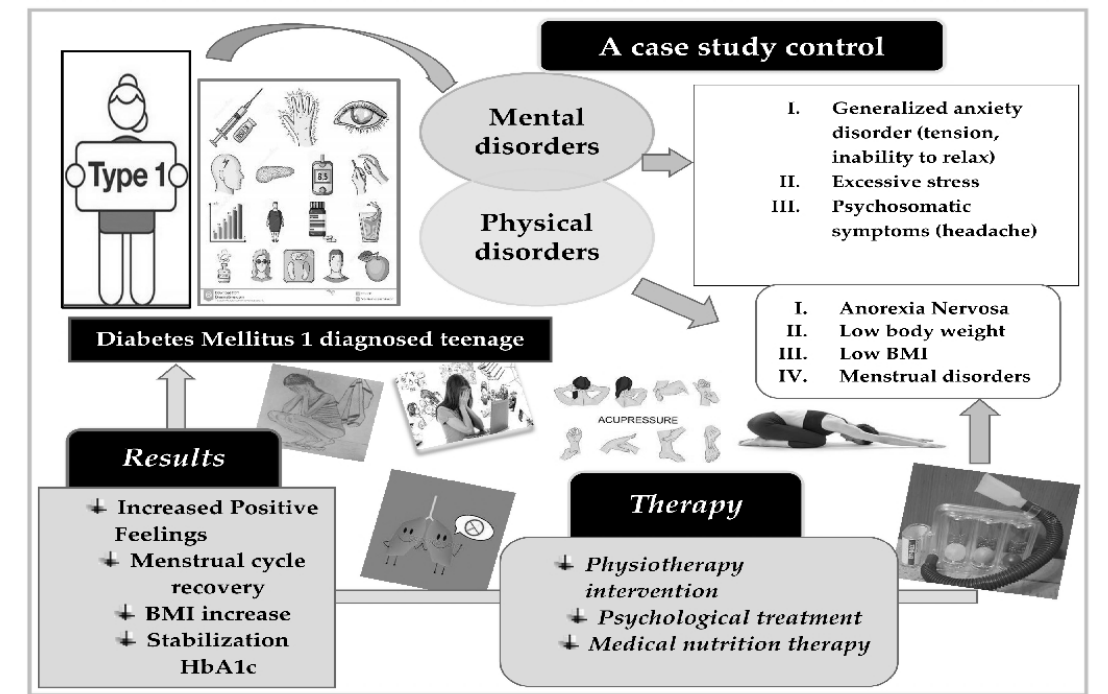
Figure 2. A description and the results of a combined therapeutic intervention in the mental and physical health of a teenage girl diagnosed with T1DM, AN, AD, and menstrual disorders.